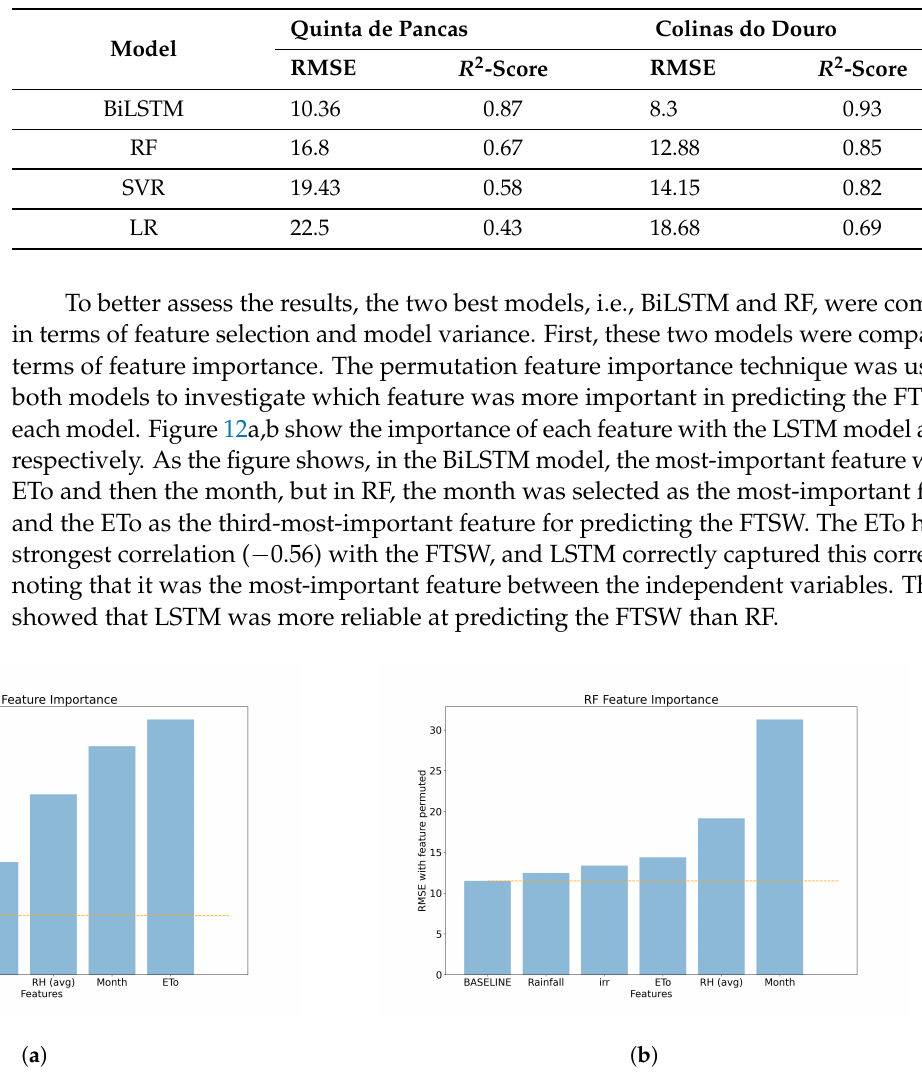
Table 9. Comparison of the performance of the trained BiLSTM model with RF in predicting the FTSW one day ahead on the Quinta de Pancas and Colinas do Douro validation sets.